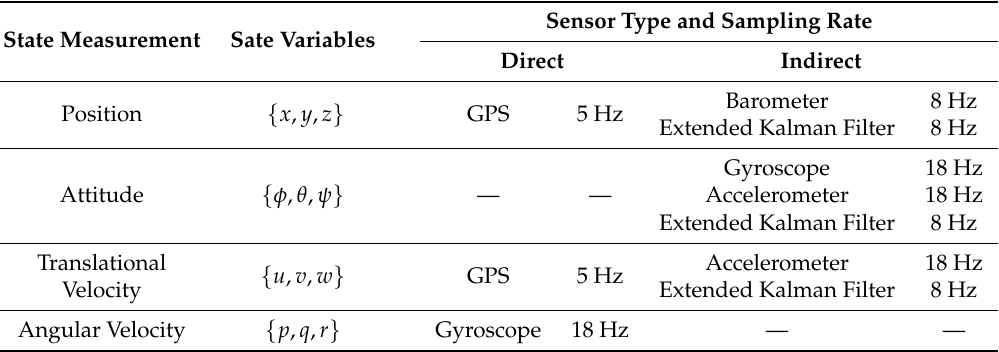
Table 1. State measurements from autopilot’s AHRS